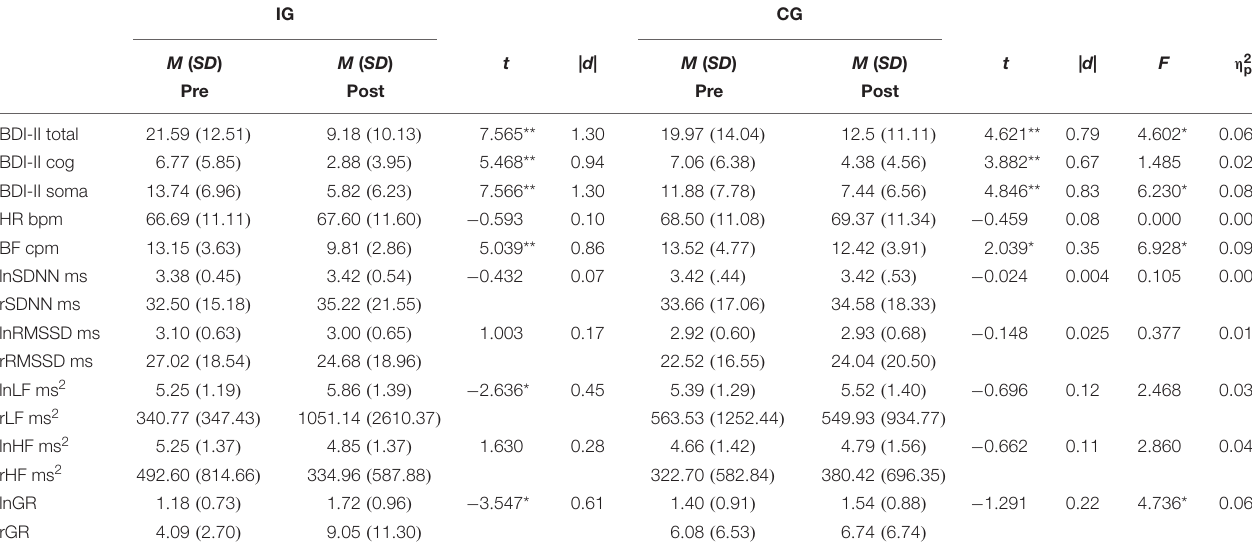
TABLE 2 | Paired t -tests by group for depression and physiological measures at baseline and post-assessment. IG